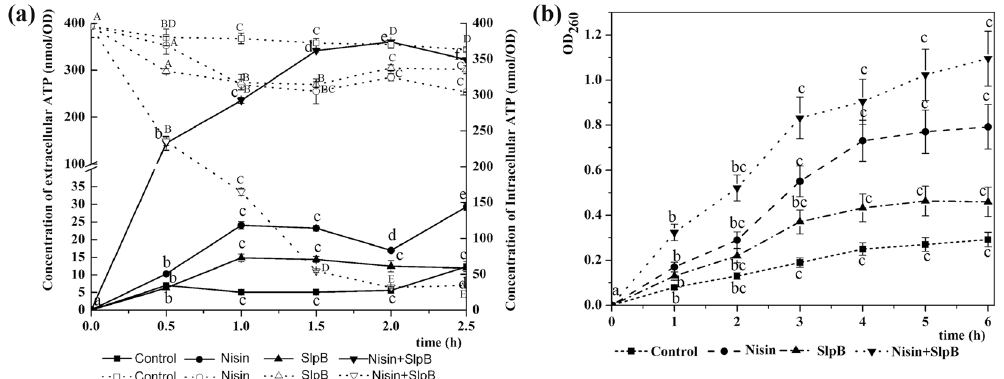
Figure 4. Intracellular and extracellular ATP levels ( a ) and extracellular UV-absorbing materials ( b ) in S. saprophyticus P2 cells treated with SlpB, nisin, or nisin + SlpB. Nisin concentration, 100 μ g/mL; SlpB concentration, 40 μ g/mL. A: Dotted line, intracellular ATP levels; unbroken line, extracellular ATP levels. Different letters in the curve indicate significant difference (p <